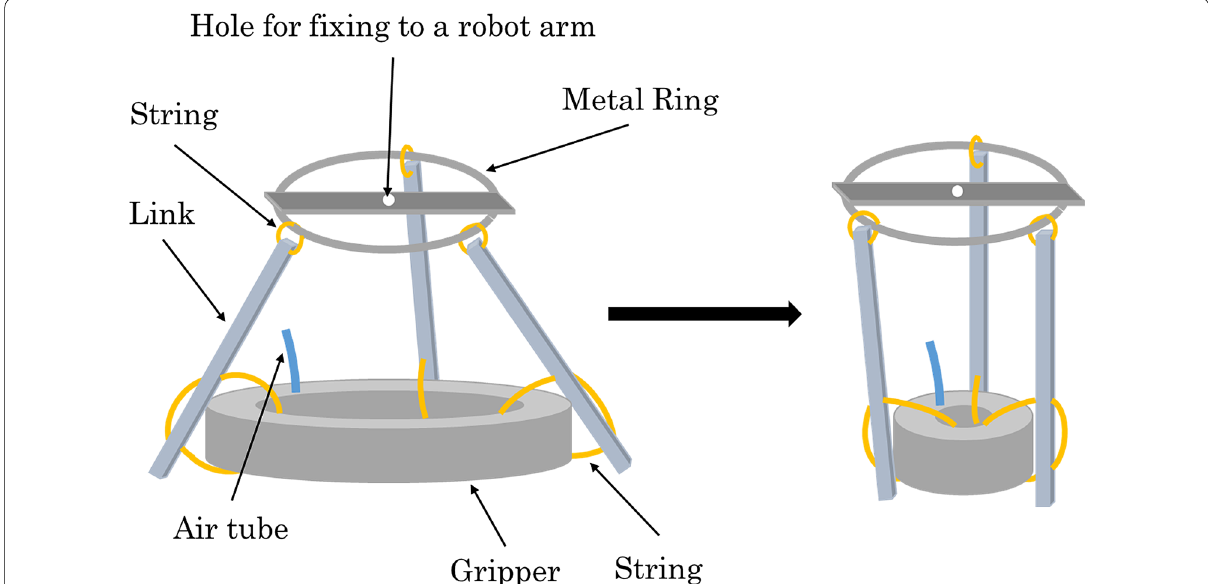
Fig. 12 Schematic illustration of the mounting device. The three links are connected with strings to the gripper and a metal ring for fixing to a robot arm. The strings are flexible so that the links move freely without interfering with the deformation of the